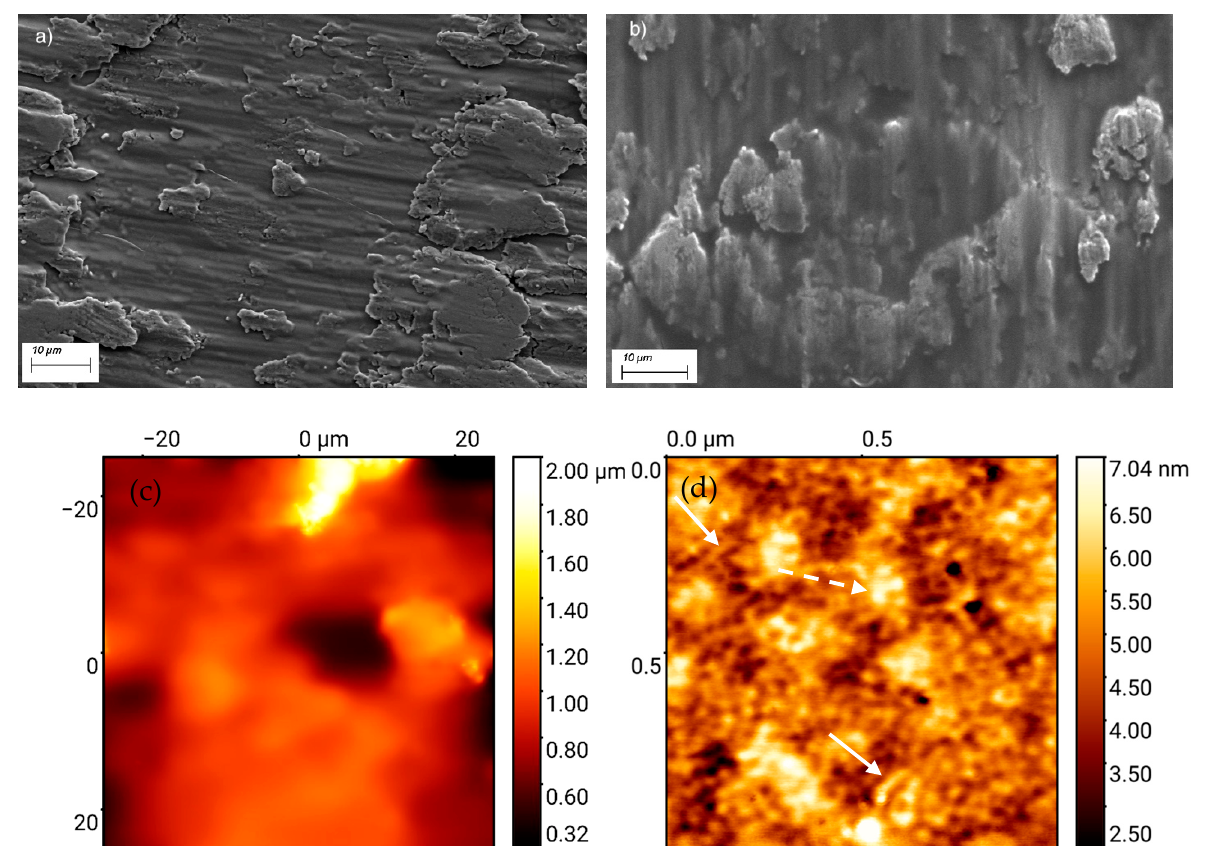
Figure 2. ( a ) Secondary electron (SE) micrograph of the plasma-cleaned TiCP substrate surface. ( b ) SE micrograph of the same surface after the polySBMA coating procedure. The surface topography is not substantially affected by the coating. ( c ) AFM amplitude micrograph of the polySBMA film on Ti, showing a largely featureless structure that demonstrates the underlying substrate roughness. ( d ) AFM amplitude micrograph at a higher resolution. The micrograph suggests nanoropes of tethered polymer brushes either laying in the plane of the surface (plain arrows) or agglomerating in domains of larger bundles (dotted arrows).